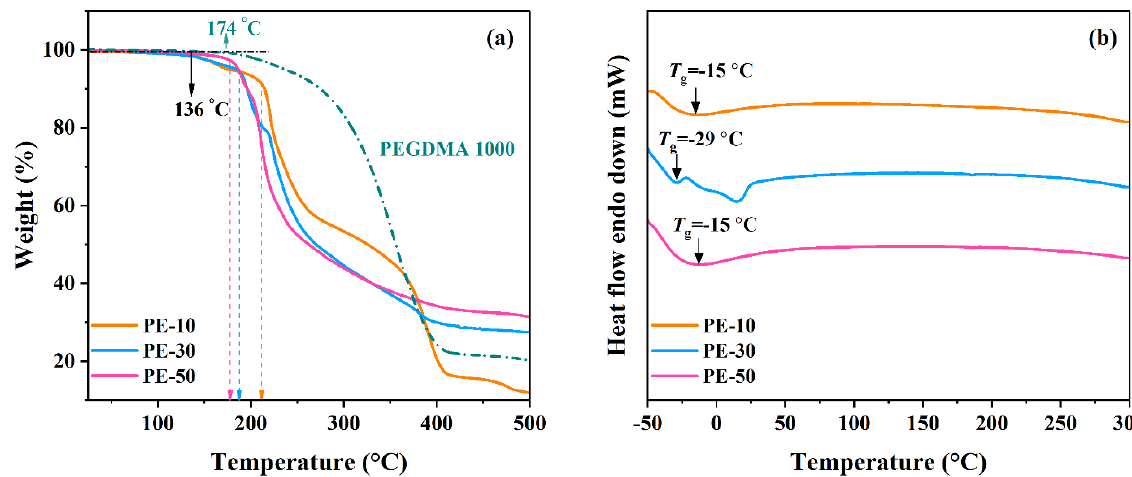
Figure 3. ( a ) TGA and ( b ) DSC curves of PEGDMA 1000 and PEs.